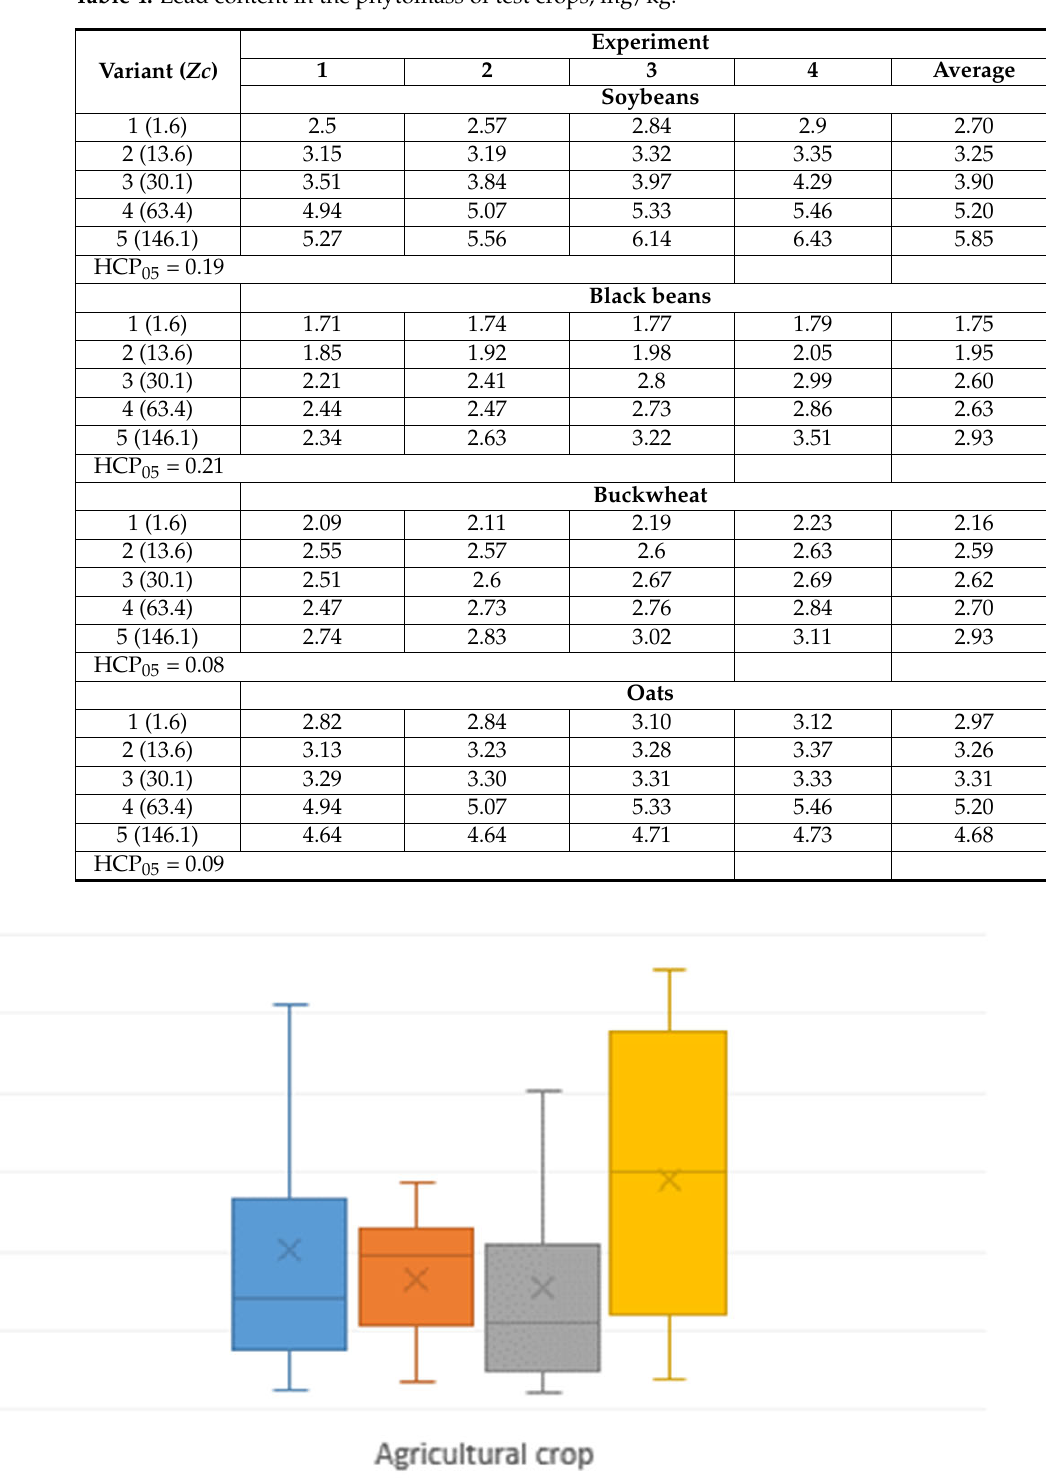
Figure 2. Diagram of zinc content in phytomass of test crops on the variants of the vegetation experiment depending on the values of the total index of soil contamination.